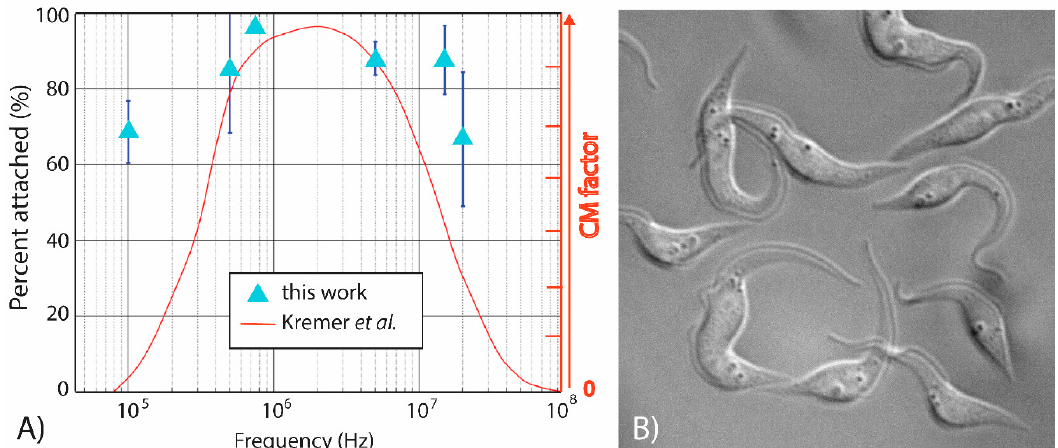
Figure 4. ( A ) Characterization of the DEP response of T. brucei across a broad frequency range, 100 kHz to 20 MHz. Dark blue bars represent the standard deviation between experiments ( n = 3). ( B ) T. brucei cultured at 29 °C in 5% CO 2 in SDM-79 media with a target density between 5 × 10 5 and 1 × 10 7 cell/mL. Courtesy of Christina Wilkinson and James Morris.